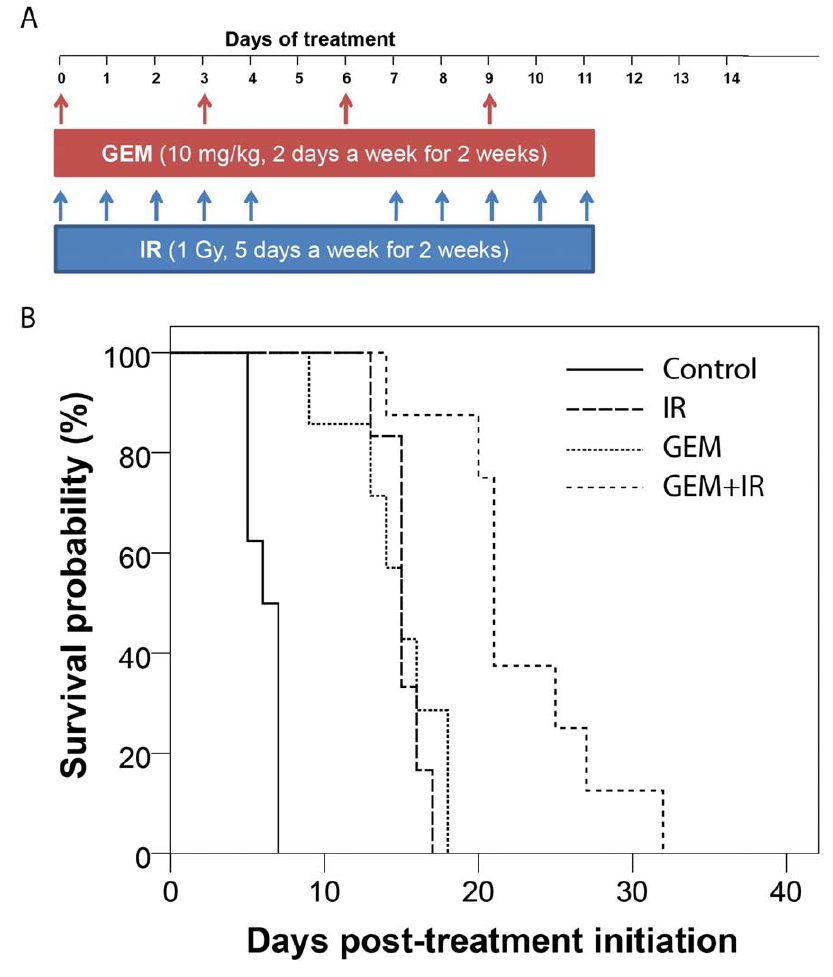
Figure 4. Treatment schedule and Kaplan-Meier survival plots are presented for each therapy in Study2 . (A) Treatment schedule schematic for Study 2 . Animals were randomized into four groups: control, IR, GEM and GEM + IR. Animals of the control group received vehicle 2 days a week for 2 weeks. Animals in the IR group received 1 Gy for 5 days as week with a two day break between treatment blocks for 2 weeks. The GEM group received 10 mg/kg GEM in saline i.p., and GEM + IR received GEM i.p. followed by 1 Gy with a 3 hour lag time between treatments. Control vehicle and GEM administration occurred every third day for a total of four doses. Arrows indicate the day of treatment. (B) Treatment groups are Controls, irradiation (IR), gemcitabine (GEM) and combination gemcitabine and irradiation (GEM +